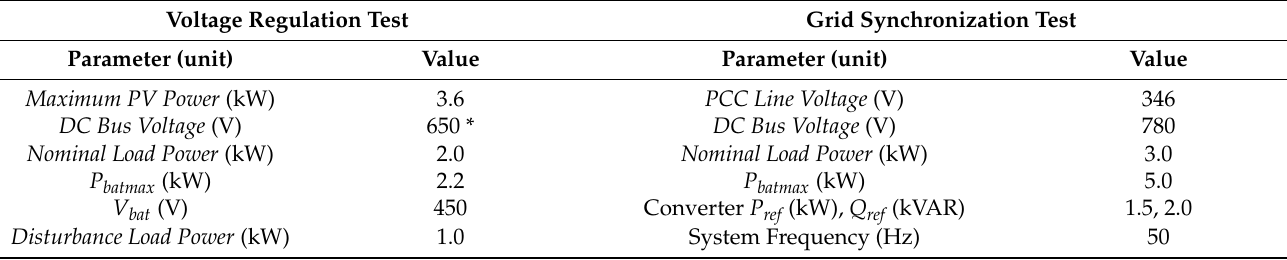
Table 3. Experimental proposed EMS test